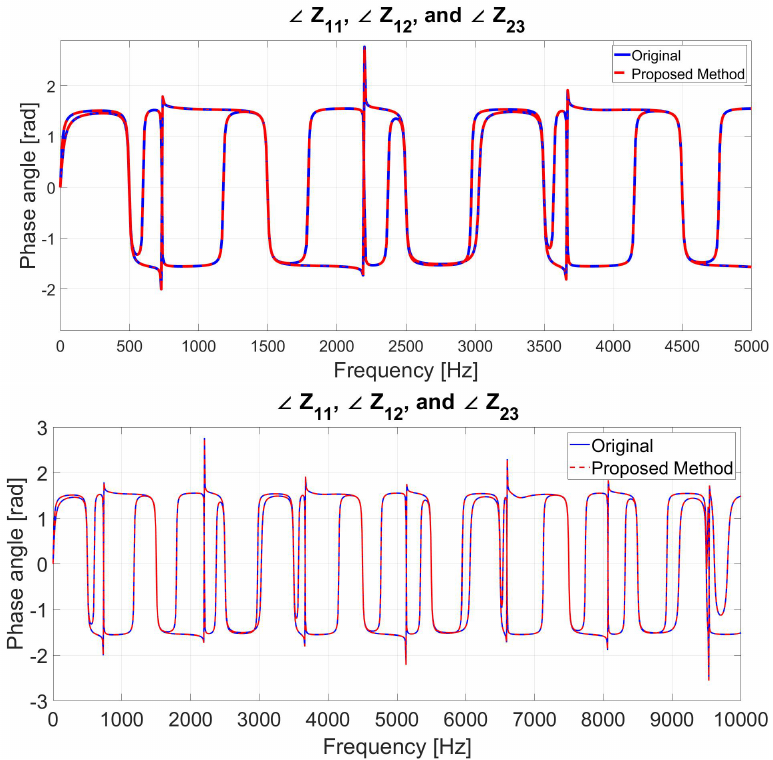
Figure 18. The angle of the measured and fitted impedance using the proposed model impedance, ∠ Z ∠ Z ∠ Z 23 11 , 12 , and